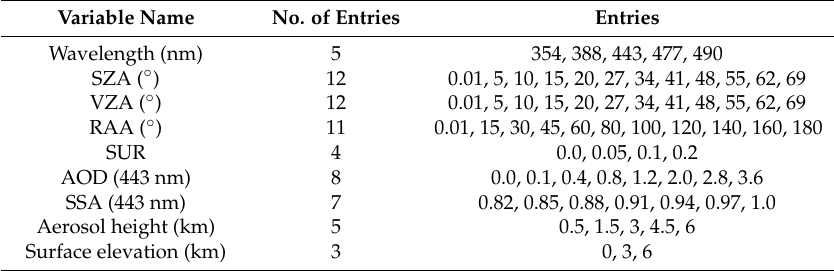
Table 4. Dimensions of the LUT for the UV-visible algorithm (SZA: solar zenith angle; VZA: viewing zenith angle; RAA: relative azimuth angle; and SUR: surface